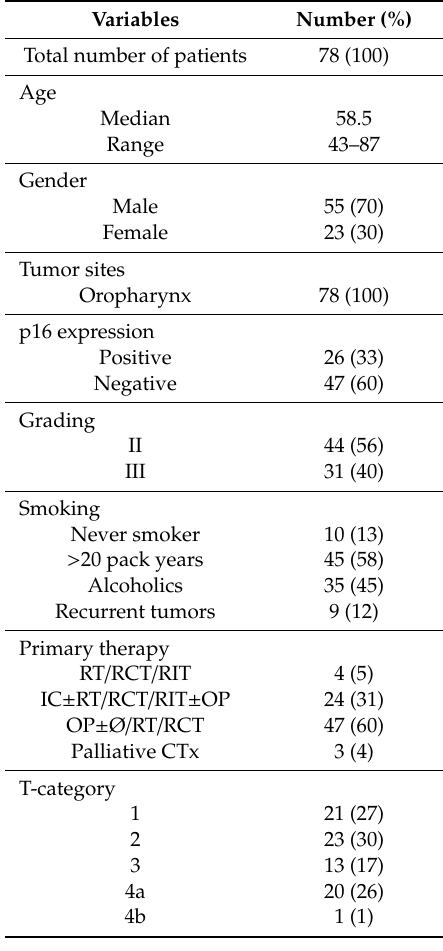
Table 1. Clinical and pathological features of the